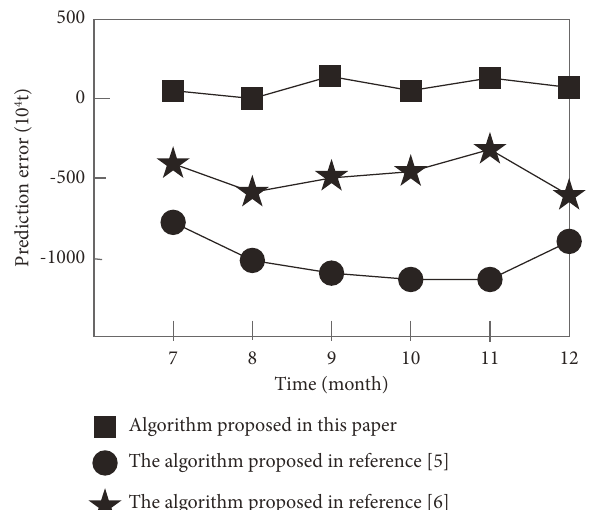
Figure 4: Prediction error of different algorithms.